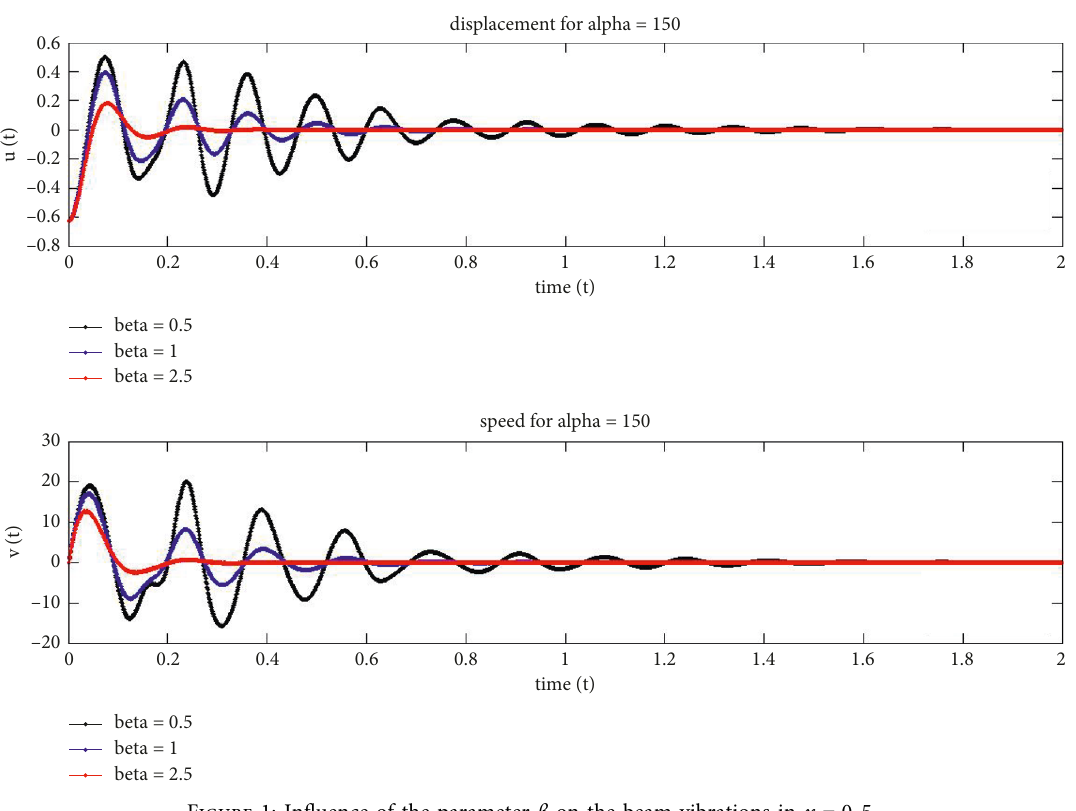
Figure 1: Influence of the parameter β on the beam vibrations in x � 0 , 5.